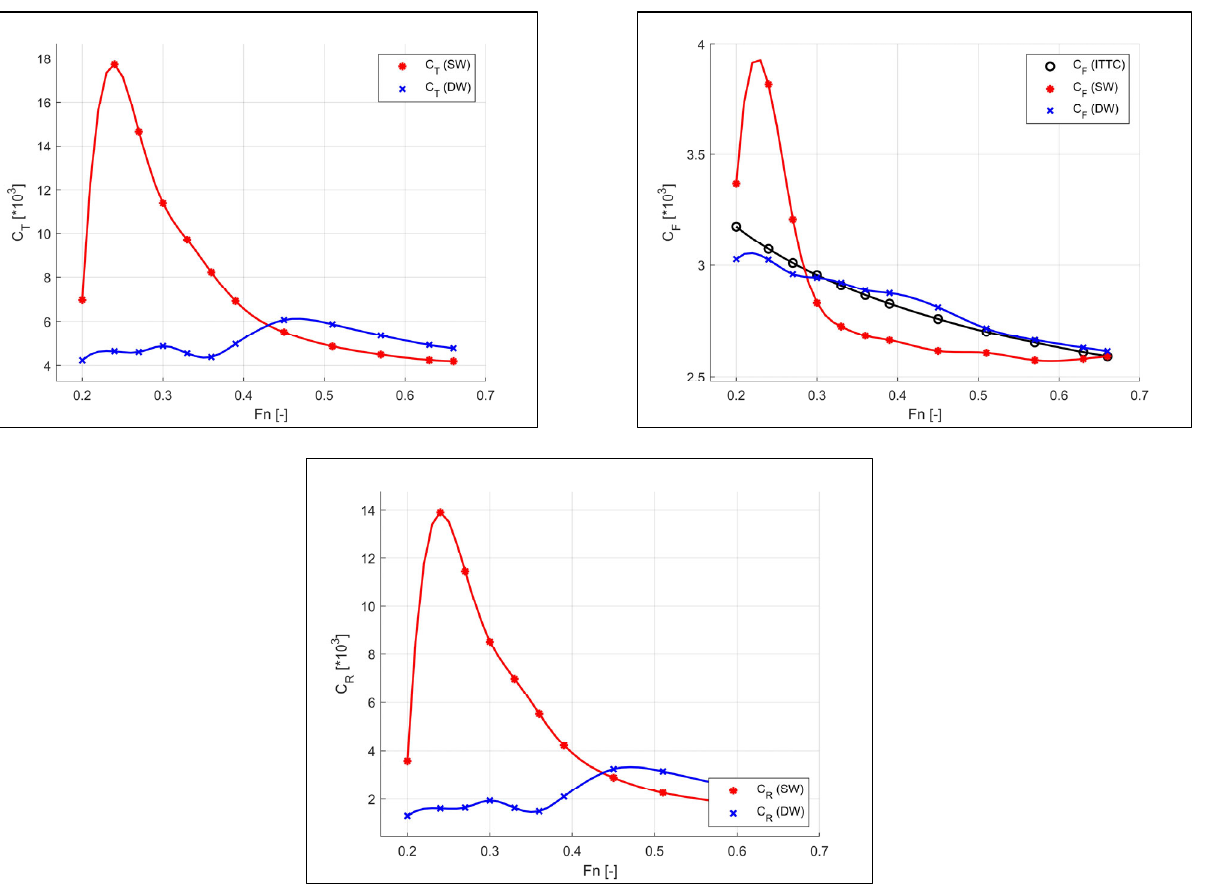
Figure 10. Total ( top - left ), frictional ( top - right ), and residual ( bottom ) resistance results of the catamaran in deep and shallow water at LC2. Table 7. Resistance results of the catamaran in deep and shallow water at LC2.